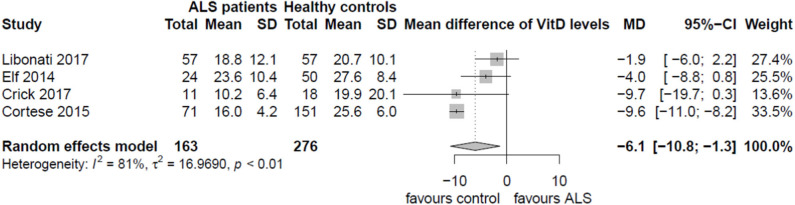
Vitamin D levels in ALS and controls.